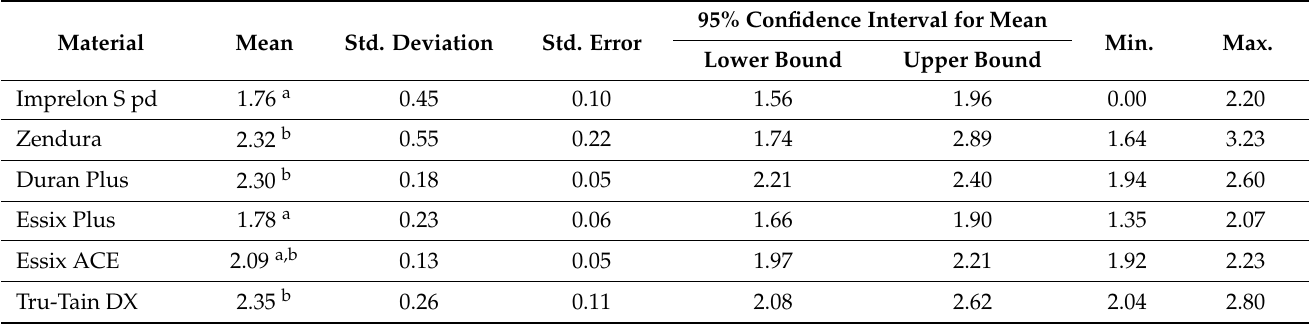
Table 2. Descriptive analysis of flexural modulus values of Group 1 (the same small letter indicates no significant difference between materials at p < 0.05